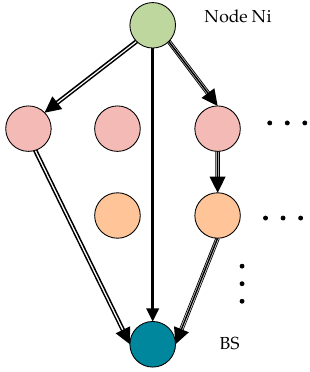
Figure 10. Paths from node (cid:1840) (cid:3036) to the BS.